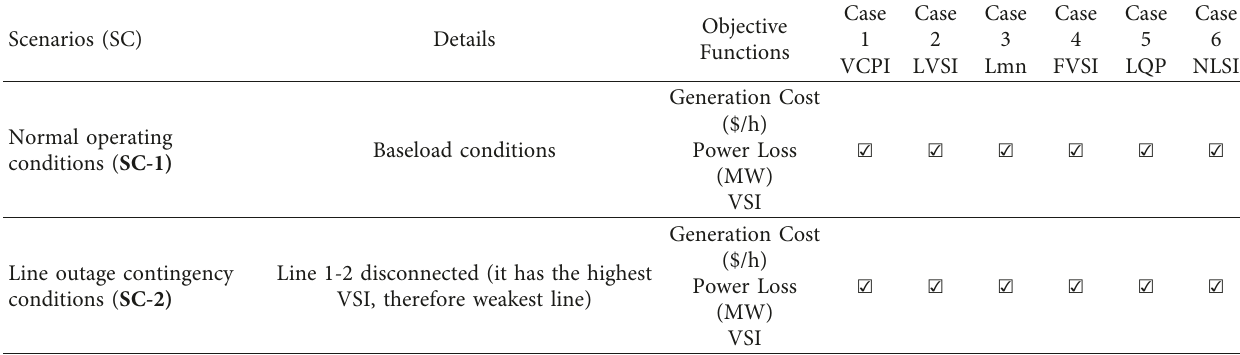
Table 5: Case studies and scenarios considered for the study.